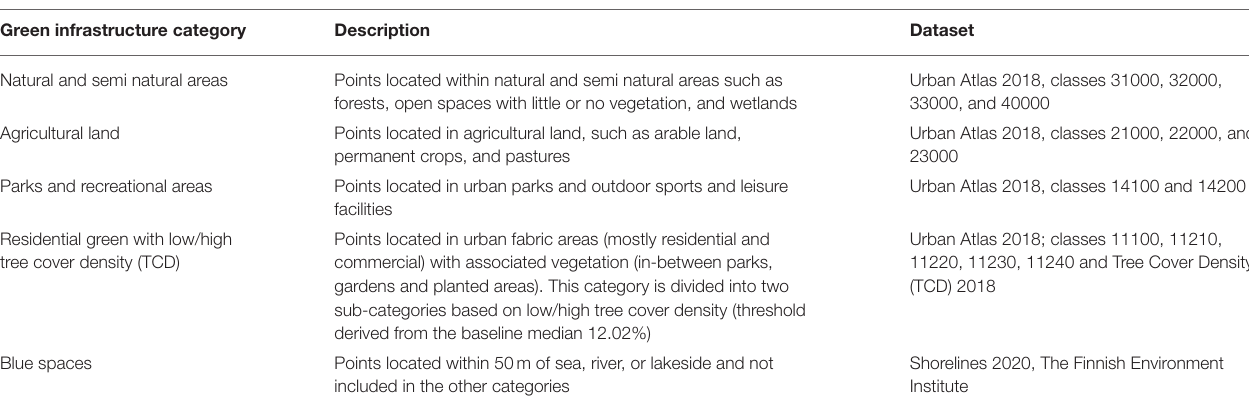
TABLE 1 | Green infrastructure classification used in the